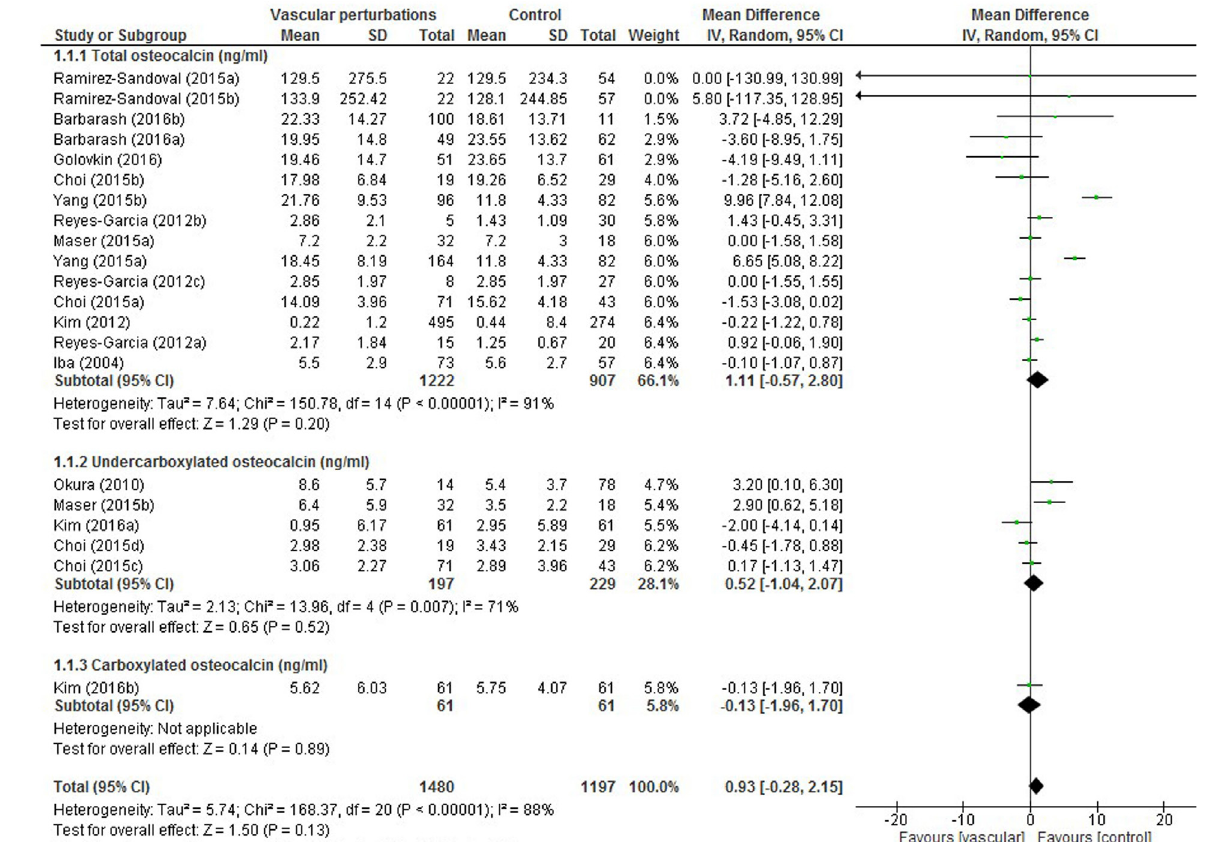
FigURe 3 | Meta-analysis examining osteocalcin (OC) concentration (nanograms per millilitre) differences between groups with and without vascular perturbations (markers of calcification or